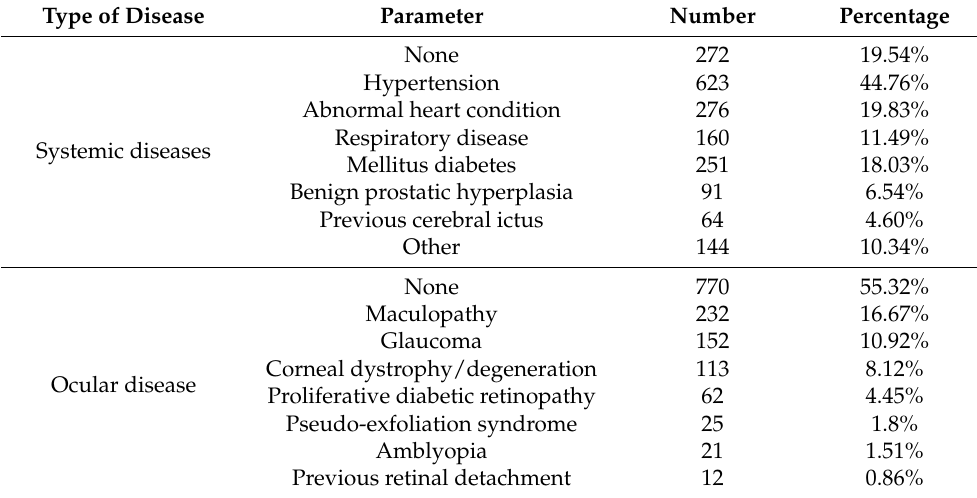
Table 2. Number and percentage of the most common ocular and systemic concomitant